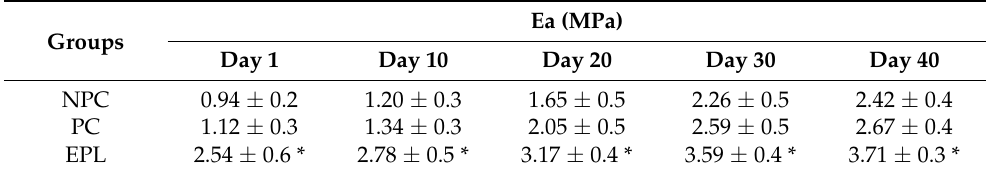
* Indicates statistically significant difference ( p < 0.01) from the respective NPC control value.